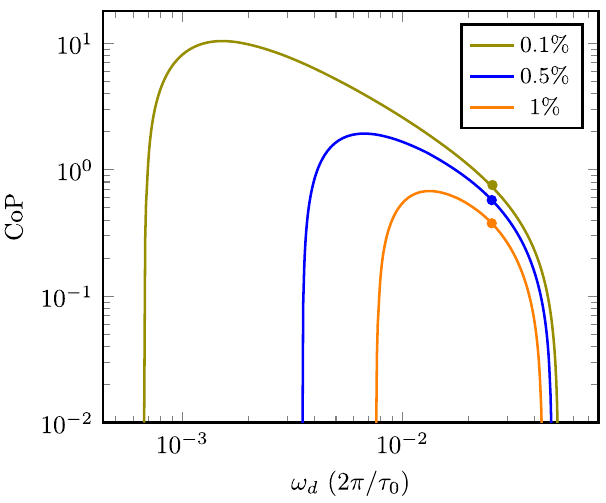
FIG. 5. Coefficient of Performance for different values of opposing thermal gradient j Δ T j (0.1%, 0.5%, and 1% of T 1 ). The points in each curve indicate the driving frequency for which the cooling power is maximum. The parameters in this case are Δ C=C ¼ 0 . 6 and τ 3 τ d ¼ 0